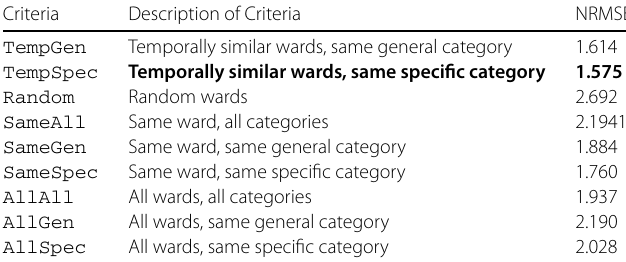
Table 1 Comparative analysis of different similarity